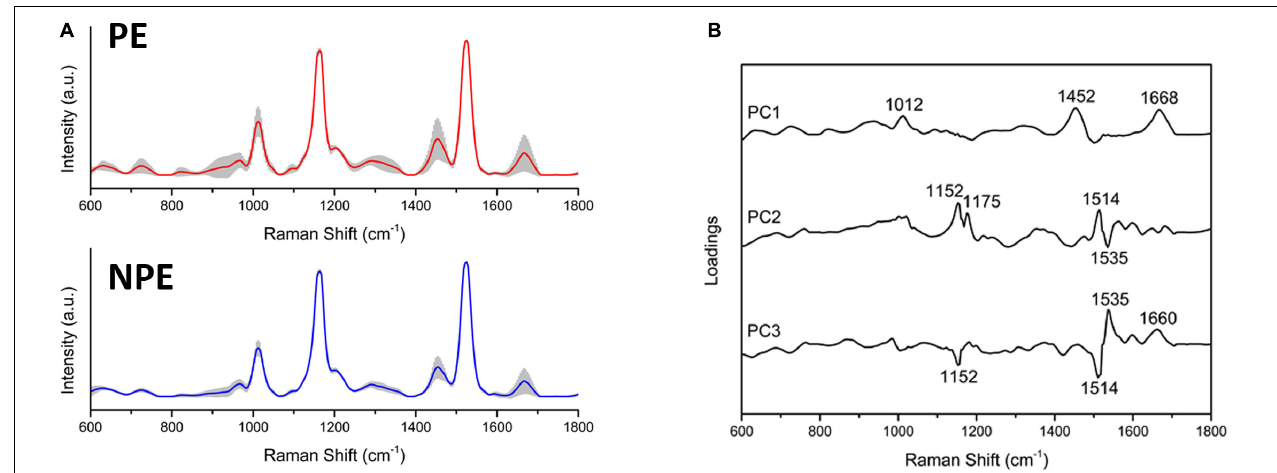
FIGURE 4 | Preeclamptic and non-preeclamptic serum biochemical signatures. (A) The Raman spectra represent the averages of Raman spectra in the fingerprint region (600–1,800 cm − 1 ). The shaded areas correspond to the Raman bands where the main variances observed in the samples occurred. (B) Loadings of PC1, PC2, and PC3 for NPE and PE